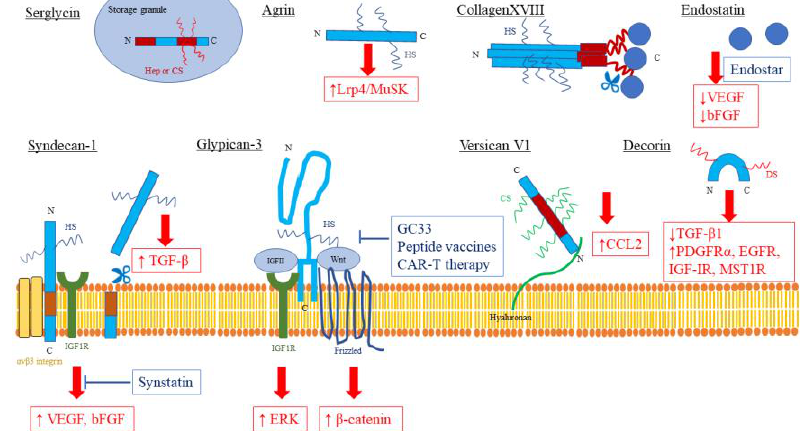
Figure 1. Proteoglycans as therapeutic targets in liver diseases. Therapeutic targets are highlighted in red boxes, and developing therapies are highlighted in blue boxes. N: amino-terminal, C: Carboxy- terminal, HS: Heparan Sulfate, CS: Chondroitin Sulfate, DS: Dermatan Sulfate, ↑ : activated, ↓ : inactivated, T-bar: inhibitor.